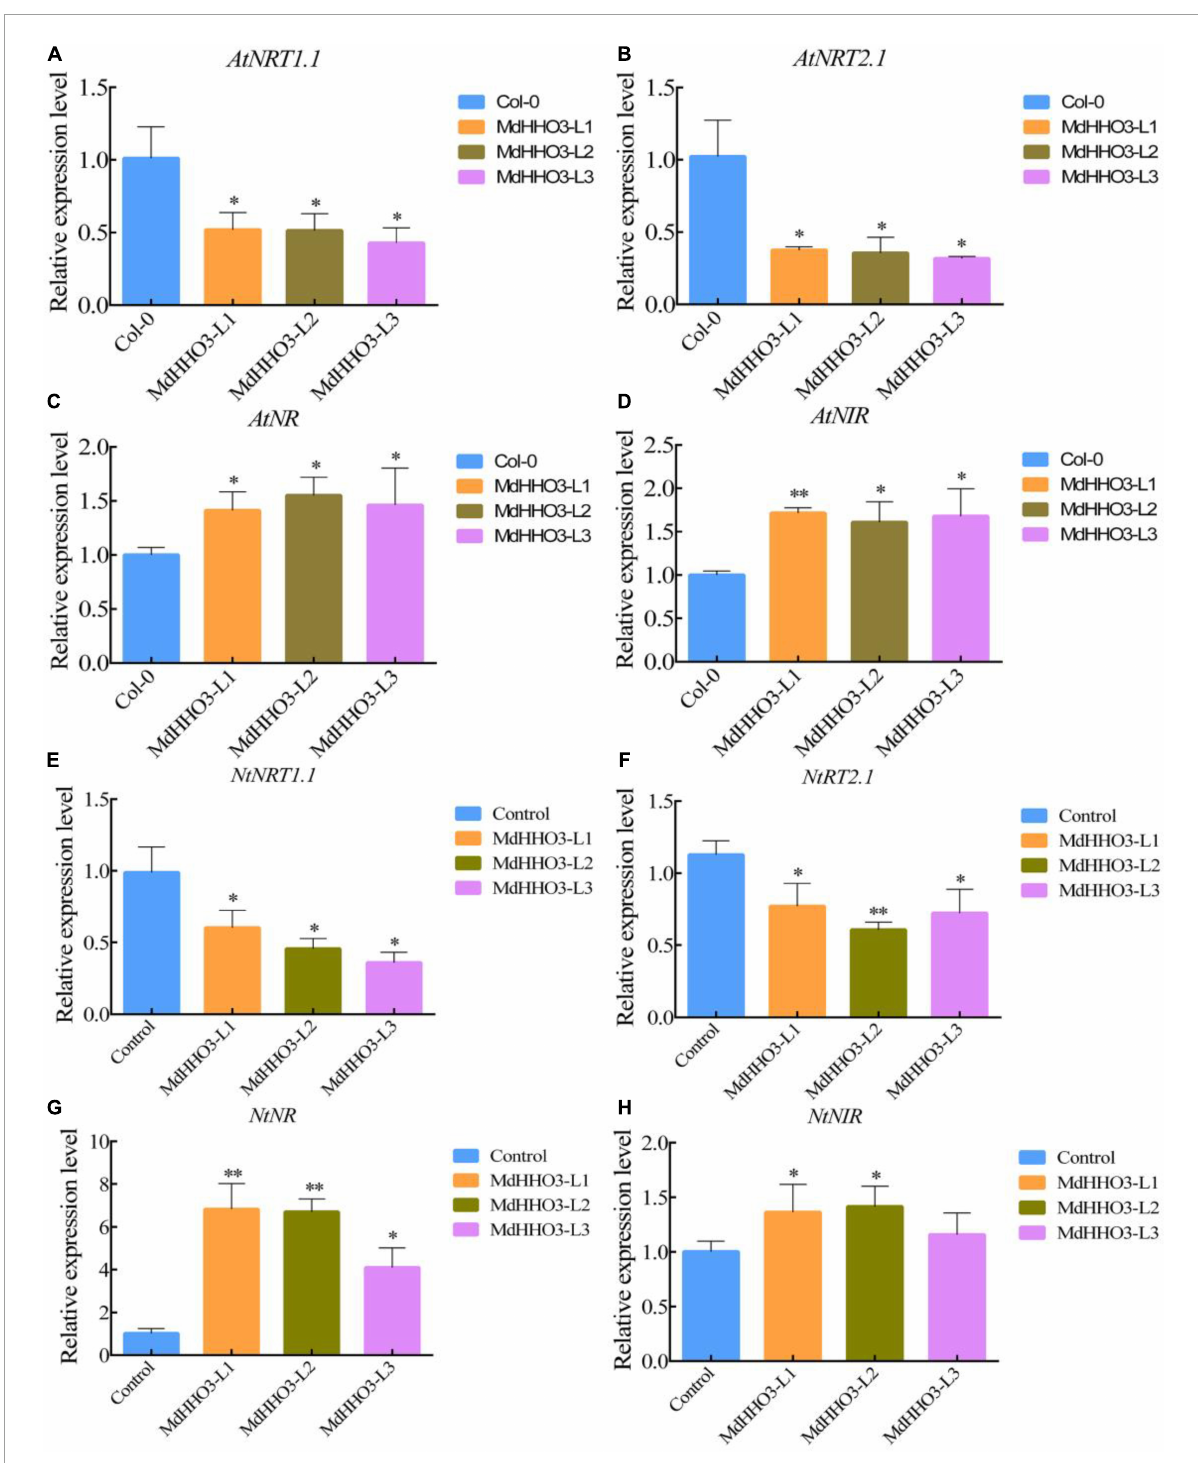
FIGURE6 The overexpression of MdHHO3 downregulates the expression of the nitrate transport-related genes and upregulates the expression of the nitrate assimilation-related genes in Arabidopsis and tobacco. (A–D) Expression of genes related to nitrate transport ( AtNRT1.1 and AtNRT2.1 ) and nitrate assimilation ( AtNR and AtNIR ) in the wild-type (Col-0) and MdHHO3 -overexpressing Arabidopsis . (E–H) Expression of genes related to nitrate transport ( NtNRT1.1 and NtNRT2.1 ) and nitrate assimilation ( NtNR and NtNIR ) in wild-type (Control) and MdHHO3 -overexpressing tobacco. Three biological replicates of each sample were included, and the data are expressed as the means ± SDs ( n = 3). Significant differences were detected by a t -test: ∗ P < 0.05 and ∗∗ P <